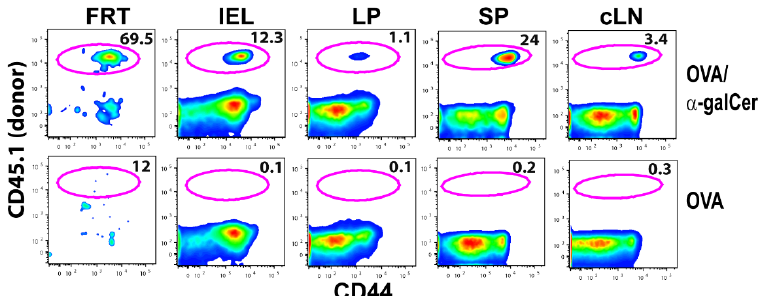
Figure 1. IN vaccination preferentially induces OVA specific CD8 + T cells in FRT. Plots show frequency of OT-I T cells among CD8 + T cells present in FRT, intestinal intraepithelial lymphocytes (IEL), lamina propria (LP),spleen (SP), and cervical LN(cLN) six days after IN vaccination with either OVA plus α GalCer or OVA alone. Table 1. Average frequency (± std. dev) of antigen specific CD8 + T cells detected in immunized mice.